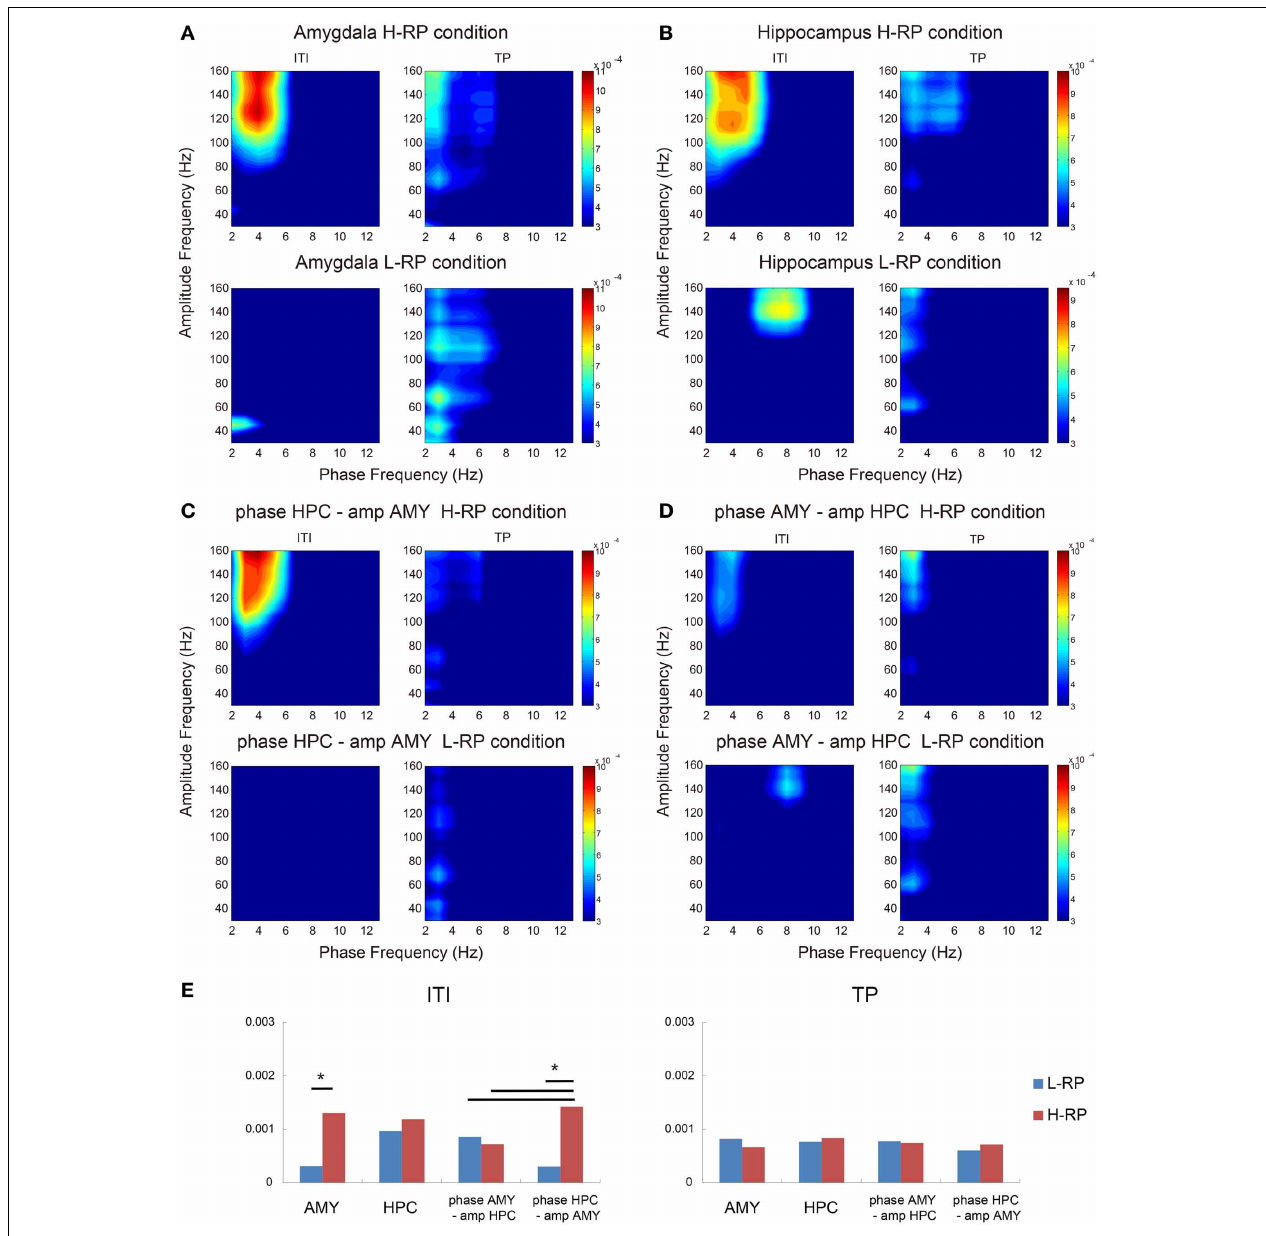
FIGURE 8 | Phase-to-amplitude mean comodulograms plotted for ITIs and trial periods. (A) Within the amygdala under the H-RP (upper) and L-RP (lower) conditions. The ordinates indicate the ranges of frequency bands in fast oscillations modulated by the phase of slow oscillations. The abscissas indicate the ranges of frequency bands in slow oscillations modulating the amplitude of fast oscillations. Colors in the graph indicate the strength of MI.